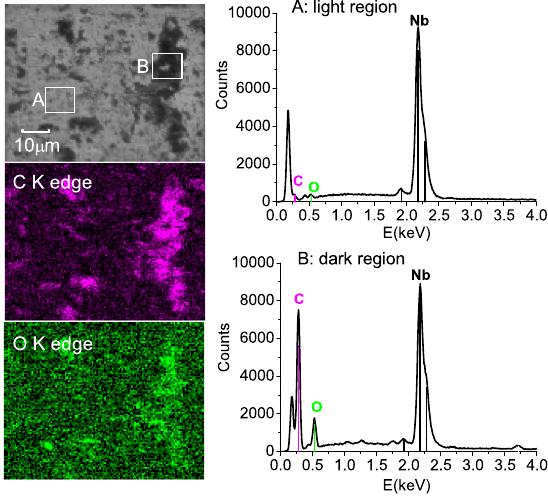
FIG. 10. Left: EDX mapping of carbon and oxygen content of a region on the bent foil. Right: EDX spectra taken in light and dark regions as indicated in the top left image.